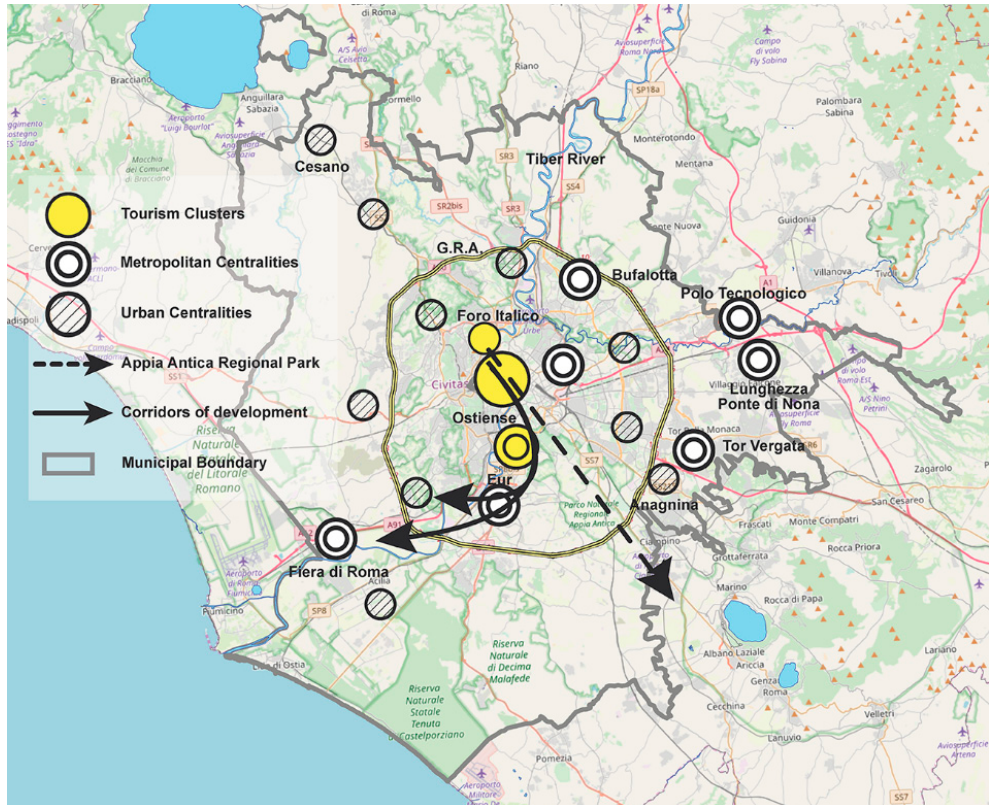
Figure 3. Spaces of Rome’s development and tourism clusters. A synthesis. Source: own elaboration.